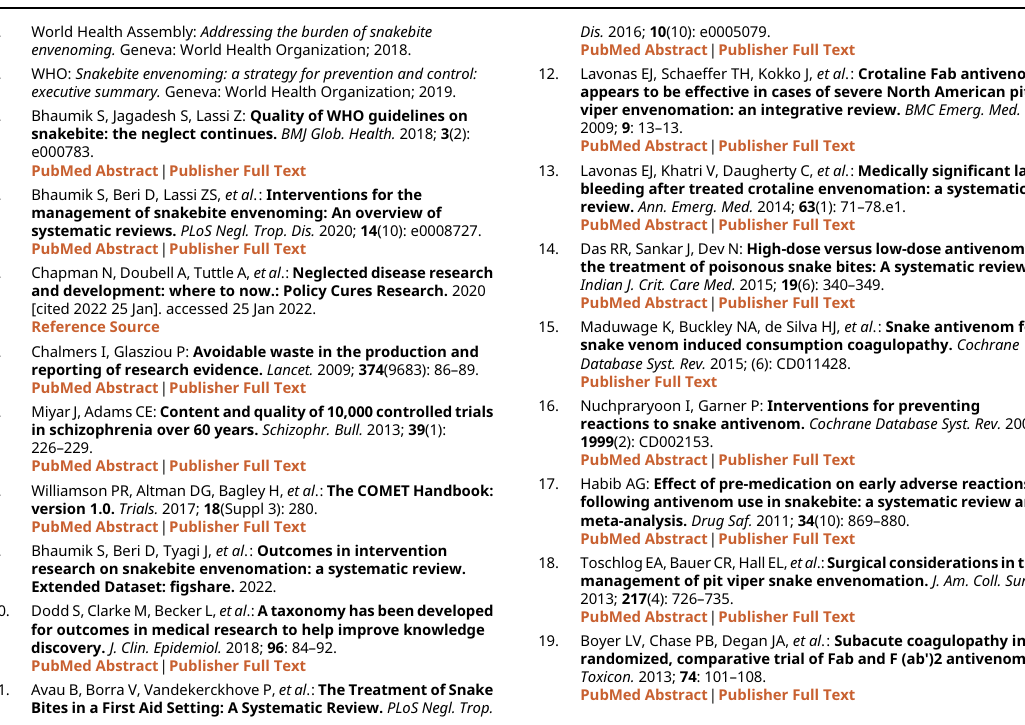
Figshare. Outcomes in intervention research on snakebite envenomation: a systematic review. DOI: